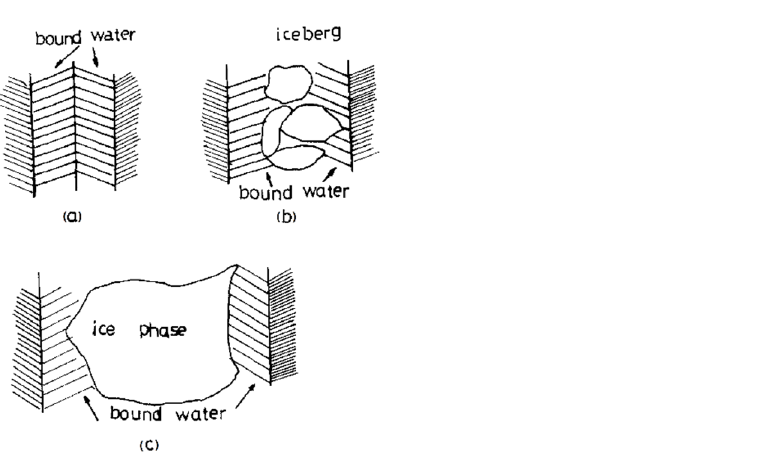
Figure 18. Schematic fragments in two channelsC at the temperature below 0 ◦ C: ( a ) narrow pores (2–10 nm)—water is bound to the pore walls and cannot transform into ice; ( b ) increased pore width—water molecules, that are far from the pore walls, tend to transform into microcrystals of ice; ( c ) a separate ice phase. Reprinted with permission from Ref. [108]. Copyright © 2022 Published by Elsevier